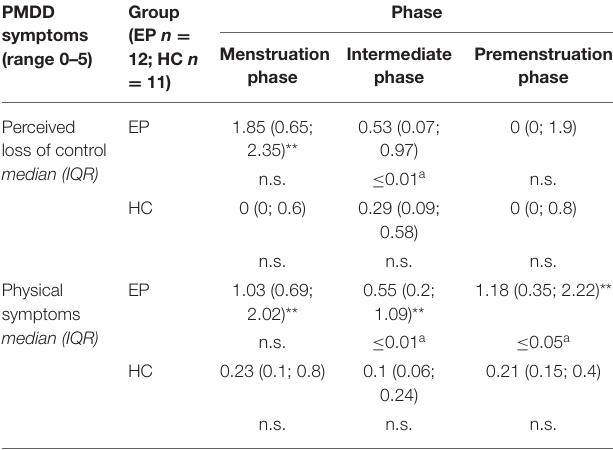
menstruation phase. Group comparisons indicated higher